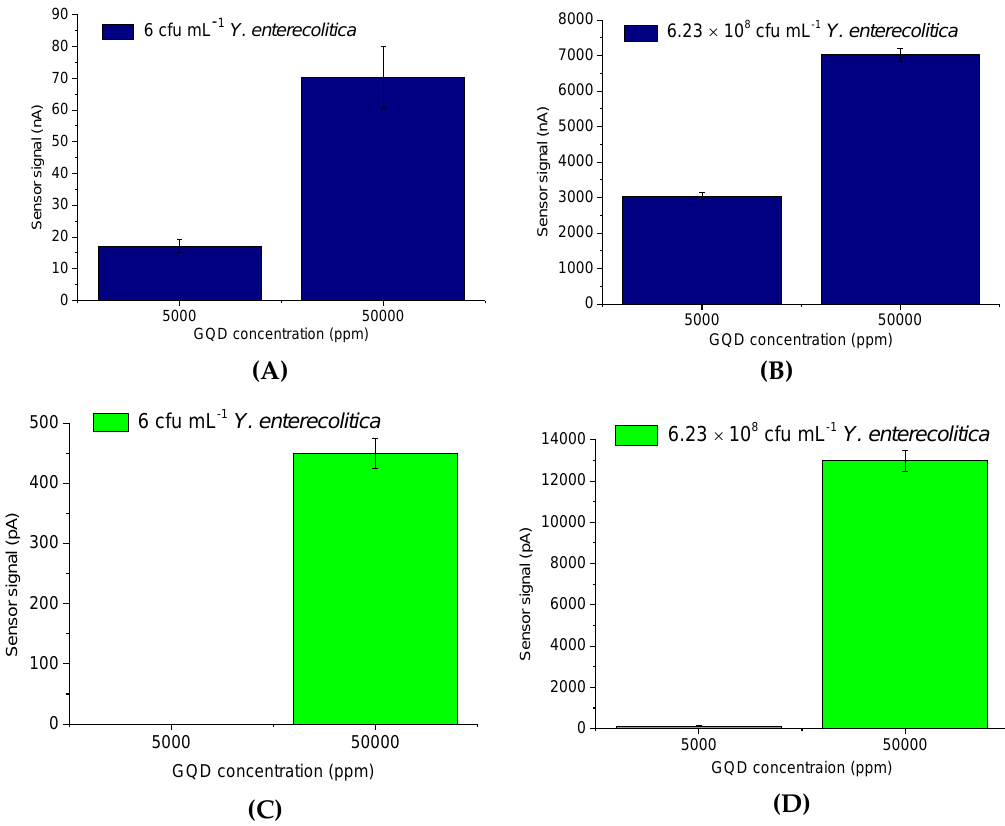
Figure 6. Optimization of GQD concentration for milk ( A , B ) and serum ( C , D ) assays by testing two different concentrations (6 and 6.23 × 10 8 cfu mL − 1 ) of Y. enterecolitica ( n = 3).